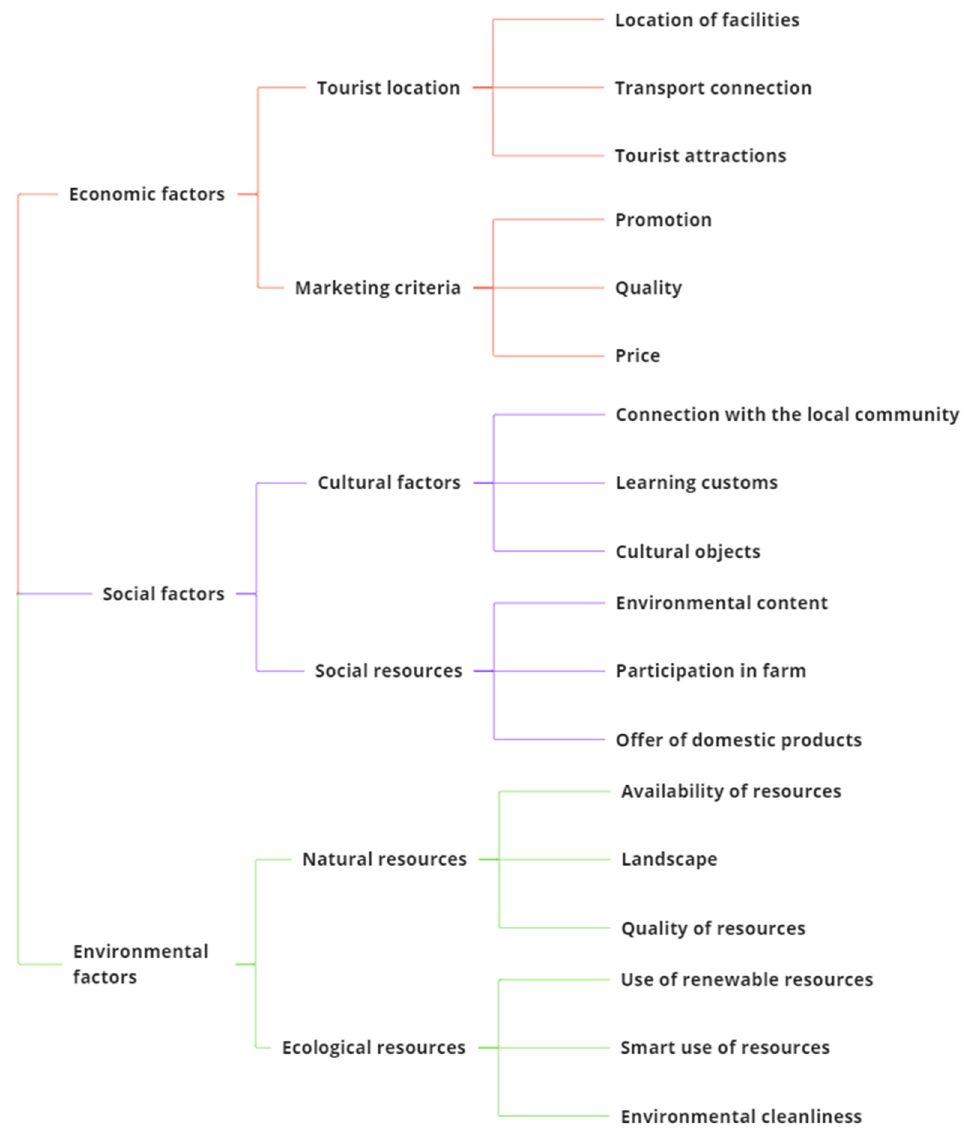
Figure 1. Structure management of sustainable development of rural tourism in BIH.